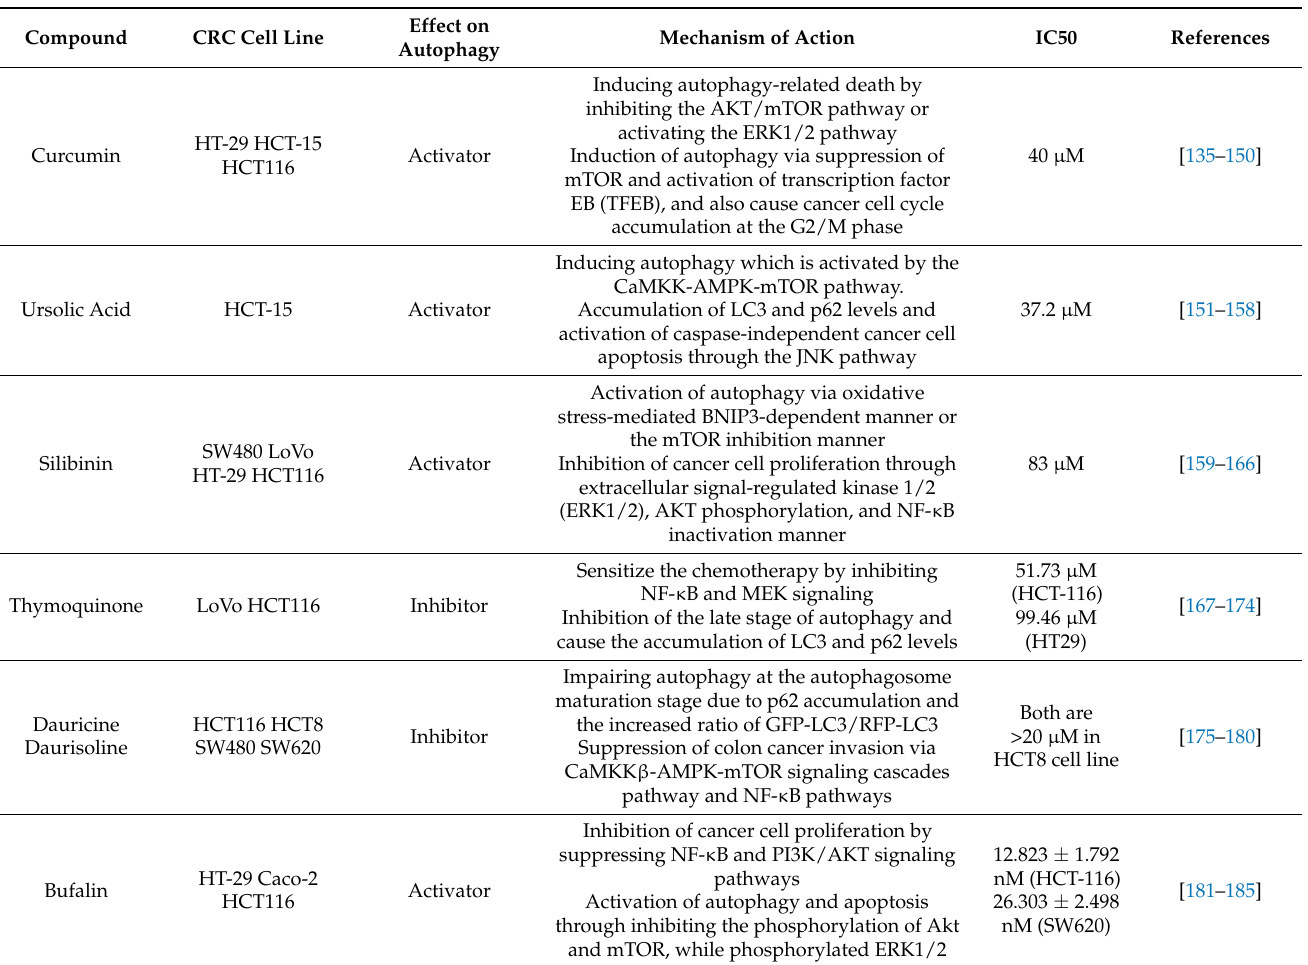
Natural compounds as modulators of autophagy for colorectal cancer prevention and